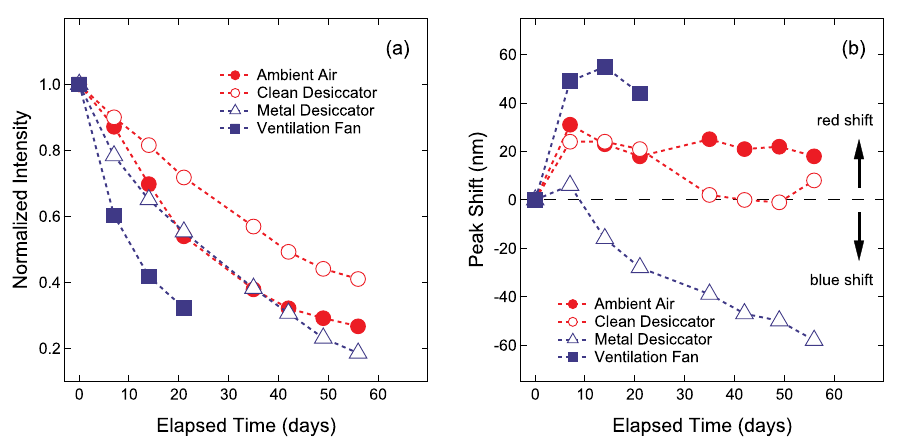
Figure 8. ( a ) Normalized extinction intensity and ( b ) peak shift of the localized surface plasmon resonance (LSPR) band of Ag NPs stored in ambient air (filled circles), inside the clean desiccator (open circles), inside the metal desiccator (open triangles) and near the ventilation fan (filled squares) plotted as a function of elapsed time.